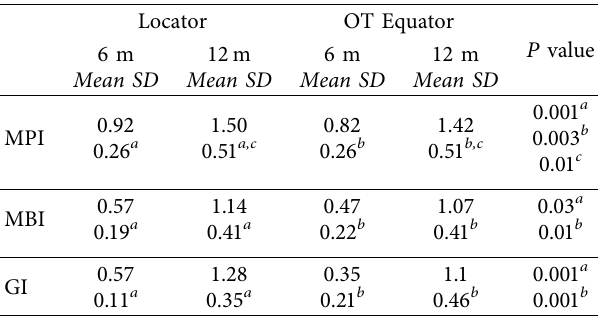
Table 2: Peri-implant-tissue change with both attachments after 6 and 12 months of implant loading. ∗